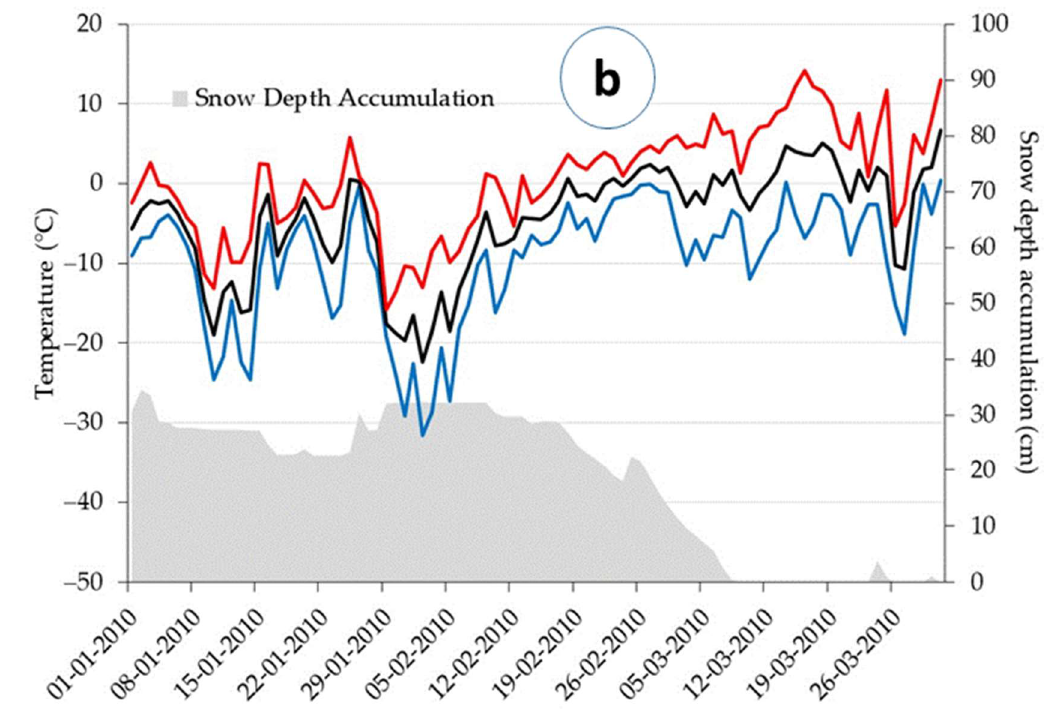
Figure 1. Variation of maximum (red), mean (black), and minimum (blue) daily air temperatures (January-March) at the Grandes-Piles forest nursery (Québec, QC, Canada) in ( a ) 2009 and ( b ) 2010. The areas in gray indicate snow depth accumulation.